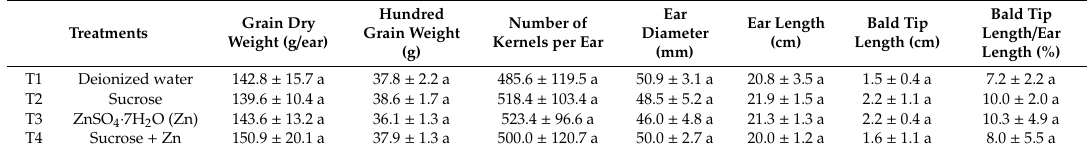
Table 4. Maize agronomic traits among various foliar spraying treatments in the field experiment at